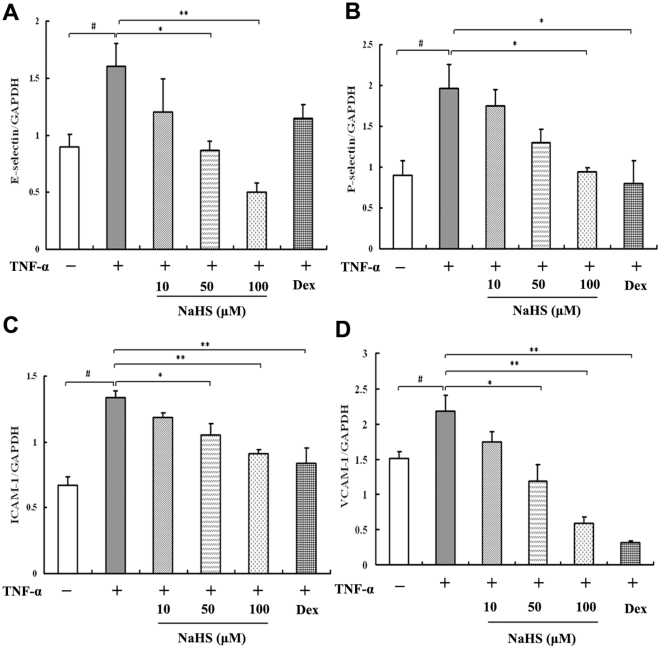
NaHS inhibited TNF-α-induced mRNA levels of adhesion molecules.HUVEC were incubated with indicated concentrations of NaHS or Dex (10 µM) for 30 min, then stimulated with TNF-α (10 ng/ml) for 4 h. mRNA levels of adhesion molecules were analyzed by real-time RT-PCR. GAPDH was used as an internal control. Bar graphs in (A), (B), (C), (D) represented the quantitative difference in mRNA levels of E-selectin, P-selectin, ICAM-1, VCAM-1, respectively, between groups. Dex concentration was 10 µM. #
P<0.05 compared with unstimulated cells, *P<0.05, **P<0.01 compared with TNF-α-stimulated cells. Data are the mean ± S.E.M of results from at least three independent experiments, each performed in duplicate.